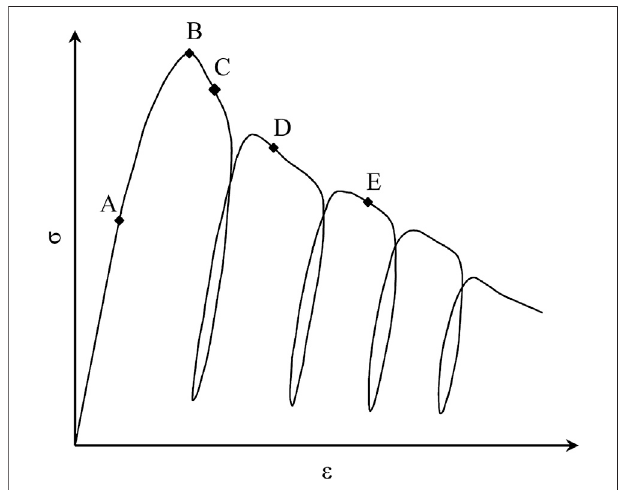
FIGURE 1 | Typical stress-strain curve of FRCC under cyclic tensile